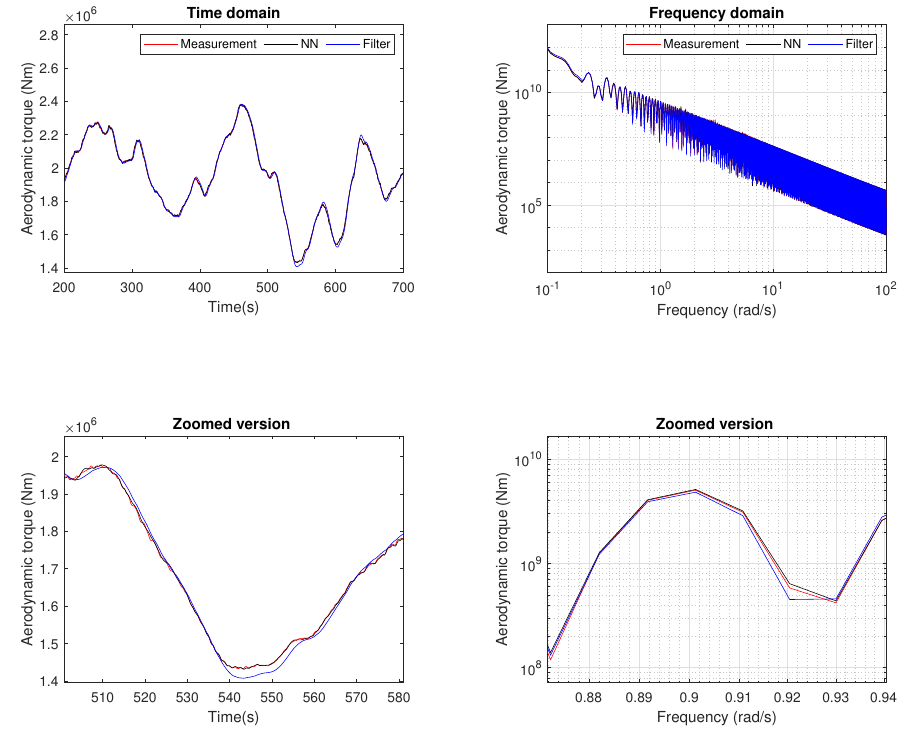
Figure 8. Scenario 2: Aerodynamic torque estimation from Turbine